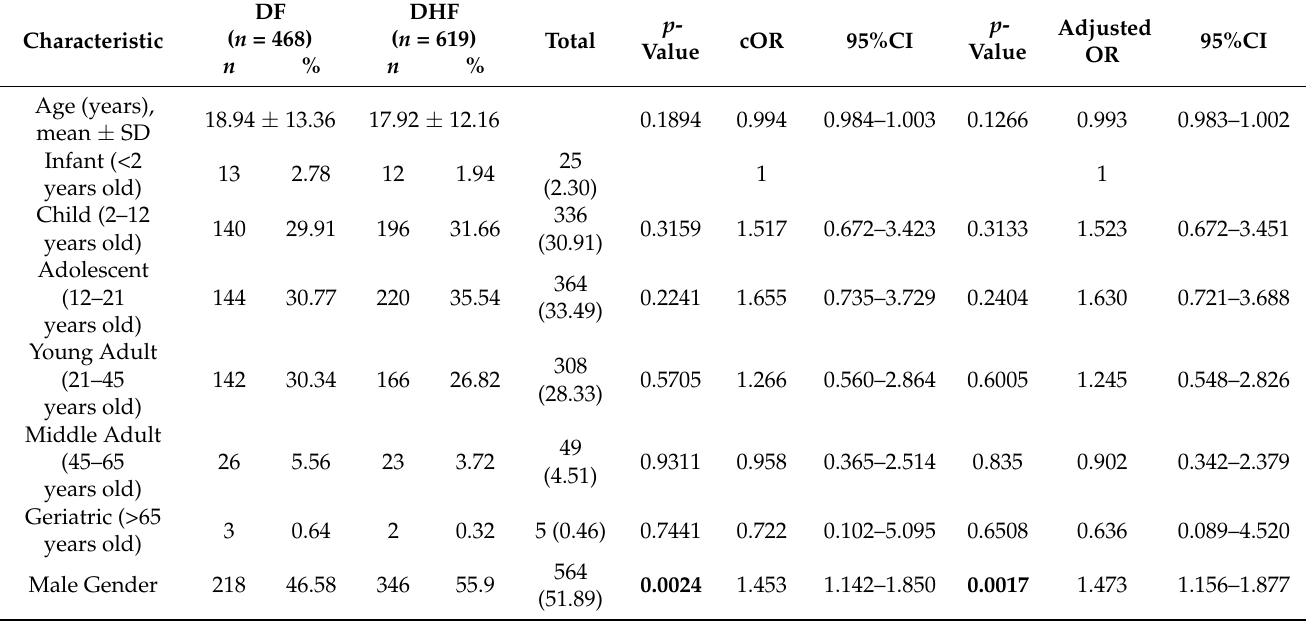
Table 1. Characteristics of Dengue